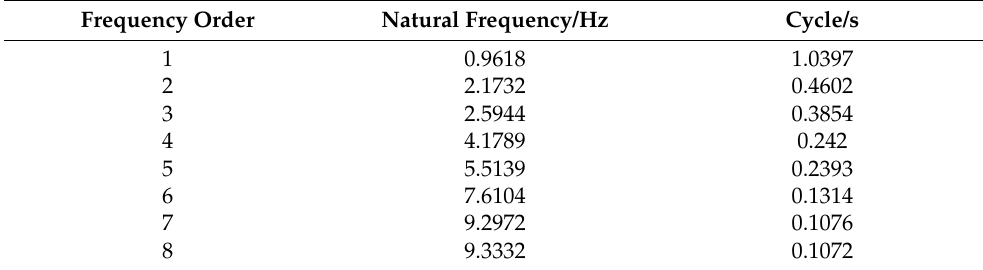
Table 4. Natural Frequencies of the Lifting Arm.